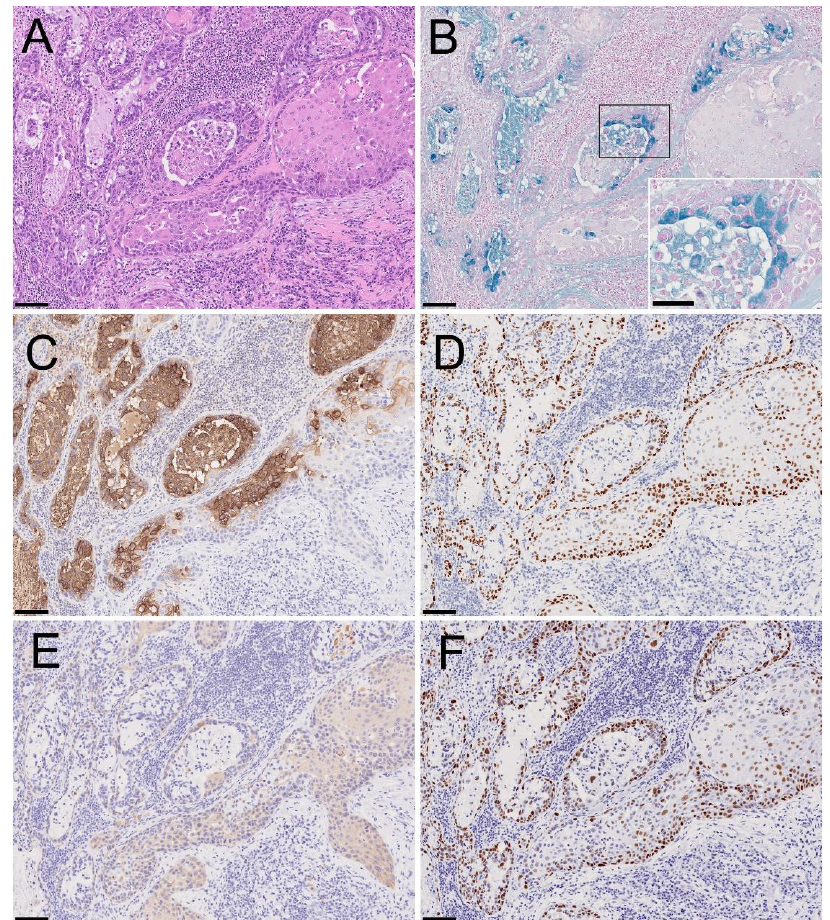
Figure 3. Immunohistochemistry and mucin staining profiles of ASC with the acantholytic feature. HE staining ( A ), Alcian blue ( B ), carcinoembryonic antigen (CEA) ( C ), p40 ( D ), cytokeratin (CK) 5/6 ( E ), and p53 ( F ). Bars, 100 μm ( A – F ) and 50 μm (inset). A representative image of ASC in metasta- sized lymph nodes shows that the glandular component with intraluminal mucin deposition tran- sitioned to the squamoid component with acantholysis ( A ). Alcian blue-positive acidic mucin was observed in the cytoplasm of the goblet-shaped cells and intraluminal mucin ( B ). CEA was strongly positive in the cytoplasm of the cancer cells, consisting predominantly of glandular structures, but also in the dissociated cancer cells in the squamoid component ( C ). Diffuse p40 nuclear positivity was observed in the squamoid and glandular cells, except for mucin-containing cells ( D ). CK5/6 was faintly positive, predominantly in the squamoid component ( E ). Diffuse strong p53 positivity was observed in both components ( F ).